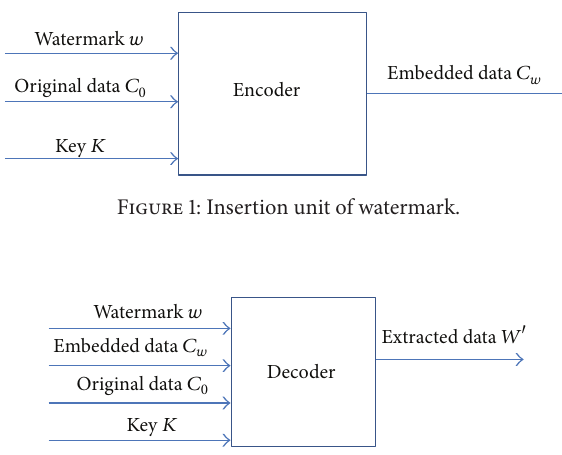
Figure 2: Extraction unit of